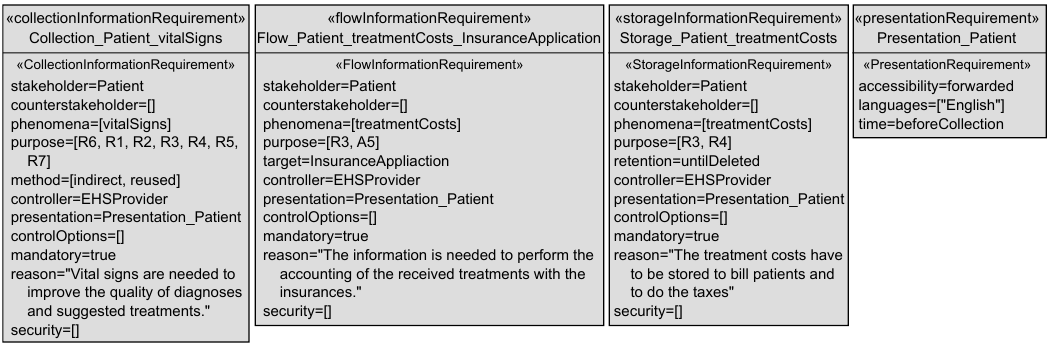
Figure 16. Examples of generated transparency requirements for the eHealth